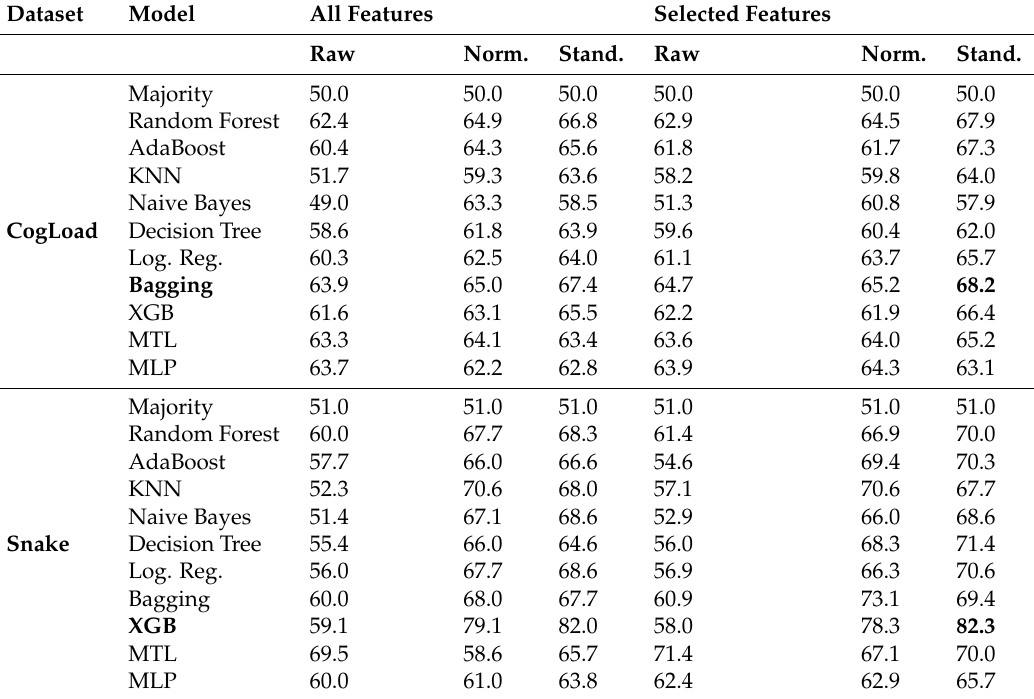
Table 8. Machine learning evaluation results with binary classification